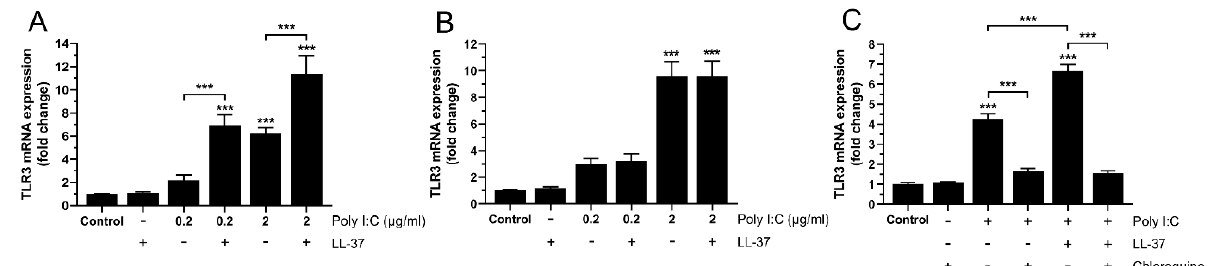
Figure 3 . LL-37/poly I:C-induced stimulation of TLR3 mRNA expression is abolished by chloroquine in BEAS-2B cells. ( A , B ) TLR3 mRNA expression was analyzed using quantitative real-time RT-PCR in cells treated with or without poly I:C (0.2 or 2 µg/mL) alone, LL-37 (1 µM) alone, or the two in combination for 6 ( A ) and 24 h ( B ). ( C ) TLR3 mRNA expression was determined in cells treated with poly I:C (0.2 µg/mL), LL-37 (1 µM), or the two in combination in the presence or absence of chloroquine (2 µg/mL) for 6 h. ( A – C ) Data are presented as mean ± SEM, n = 8–12 ( A ), n = 6–8 ( B ) and n = 4 ( C ) in each group. Statistical significance was calculated using a one-way ANOVA, followed by Tukey’s post hoc test. *** represents p < 0.001 vs. control or p < 0.001 for comparisons indicated by the bars.